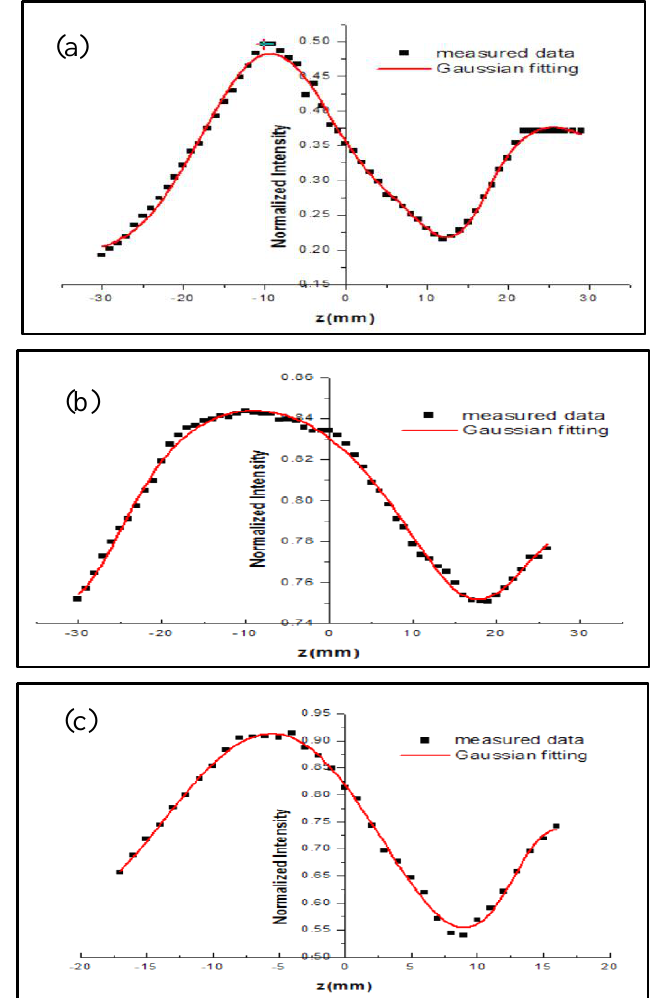
Fig.4: The division of the CA by OA Z-scan curves for the oil samples at 632.8 nm for, (a) B sample, (b) K1 Sample, (c) K2 sample